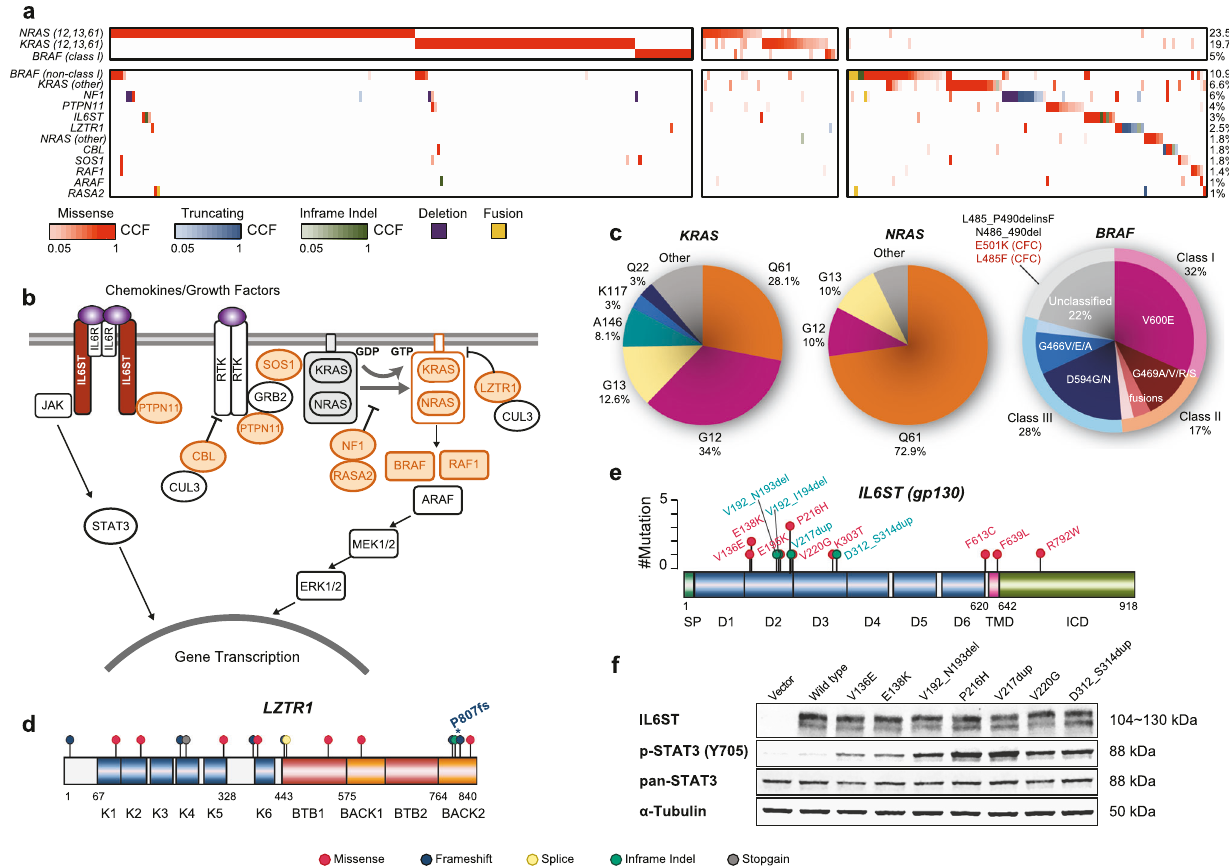
Fig. 3 Alterations of the RAS-MAPK and JAK-STAT3 pathway in relapsed refractory multiple myeloma. a Heatmap of RAS-RAF pathway alterations in cases with at least one mutation with CCF (cancer cell fraction) ≥ 0.05 ( n = 354) (Methods). Clonal mutations of RAS and BRAF ( RAS Q61, G12, G13, and BRAF V600) showed a strict pattern of mutual exclusivity (top left panel). Mutations which appeared to co-occur were subclonal and likely belonged to different clones (top middle panel). There was also a distinct group of cases with mutations associated with the Rasopathies (bottom right panel). IL6ST was also included given the reported association with SHP2 (PTPN11) b Overview of the RAS-RAF signaling pathway and summary of alterations observed in RRMM. Rasopathy-associated genes that had mutations in our RRMM cohort are highlighted in light orange. c Pie charts show the distribution of mutations in NRAS , KRAS , and BRAF across our RRMM cohort. d Lollipop plot of LZTR1 which was enriched for loss-of-function mutations. e Lollipop plot of mutations in IL6ST . f JAK-STAT3 pathway activation in HEK-293FT cells overexpressing IL6ST mutants. Western blot analyses of protein levels of IL6ST, phosphorylated STAT3(Y705); total STAT3, and a-tubulin (loading control) are shown. The experiment was repeated twice independently with similar results. Source data are provided as a Source Data fi